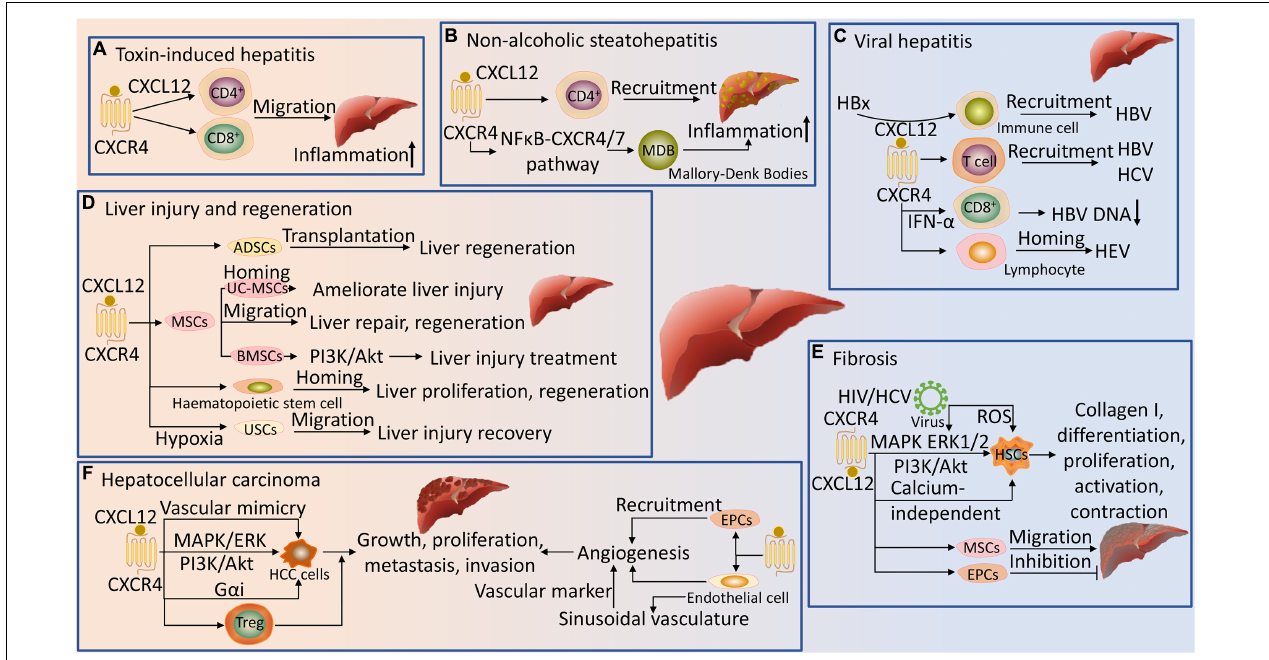
FIGURE 3 | Regulation of liver disease by CXCR4 and its ligand. (A) In toxin-induced hepatitis, the CXCL12/CXCR4 axis promotes the migration of CD4 + and CD8 + cells to the liver and induces aggregation of inflammation. (B) CXCL12 is dependent on CXCR4 to promote the recruitment of CD4 + T cells in NASH, and the NF κ B-CXCR4/7 pathway further promotes inflammation in NASH by forming Mallory-Denk Bodies (MDB). (C) The CXCL12/CXCR4 pathway is involved in the recruitment and homing of immune cells in the liver during viral hepatitis (HBV, HCV, and HEV) infection. In HBV, hepatitis B virus X protein (HBx) facilitates recruitment via CXCL12 signaling, and CXCR4 is highly expressed in CD8 + T cells after PEGylated interferon- α (INF- α ) treatment and inversely correlates with HBV DNA loads. (D) The CXCL12/CXCR4 axis promotes migration and homing of mesenchymal stem cells (MSCs), bone marrow mesenchymal stromal stem cells (BMSCs), umbilical cord-derived mesenchymal stem cells (UC-MSCs), adipose-derived stem cells (ADSCs), urine-derived stem cells (USCs) and hematopoietic stem cells to the injured liver to ameliorate liver injury and promote liver repair, proliferation and regeneration. Activation of the PI3K/Akt signaling pathway by CXCR4 in BMSCs could promote cell migration, resulting in better therapeutic effects for liver injury. Hypoxia preconditioning promotes the proliferation and migration of USCs by inducing CXCR4 signaling, leading to recovery from liver injury. (E) CXCL12 activation of CXCR4 promotes hepatic stellate cells (HSCs) differentiation, proliferation, activation and contraction via the MAPK, ERK1/2, PI3K/Akt and calcium-independent pathways, inducing collagen I production with fibrotic effects. CXCR4 HIV promotes liver fibrosis by promoting the phosphorylation of ERK1/2 on activated HSCs and inducing reactive oxygen species (ROS) production in HSCs. The CXCL12/CXCR4 axis induces migration of MSCs and endothelial progenitor cells (EPCs) into fibrotic liver, aggravating and inhibiting liver fibrosis, respectively. (F) The CXCL12/CXCR4 axis promotes HCC cells growth, proliferation, metastasis and invasion, and vascular mimicry formation via activation of heterotrimeric G proteins, MAPK/ERK and PI3K/Akt signaling pathways; and recruits Treg cells to the tumor sites to promote HCC. The CXCL12/CXCR4 axis enhances the recruitment of endothelial cells and EPCs to HCC and promotes tumor neovascularization. CXCR4 is highly expressed on endothelial cells and can be used as a novel vascular marker for vessel sprouting in HCC